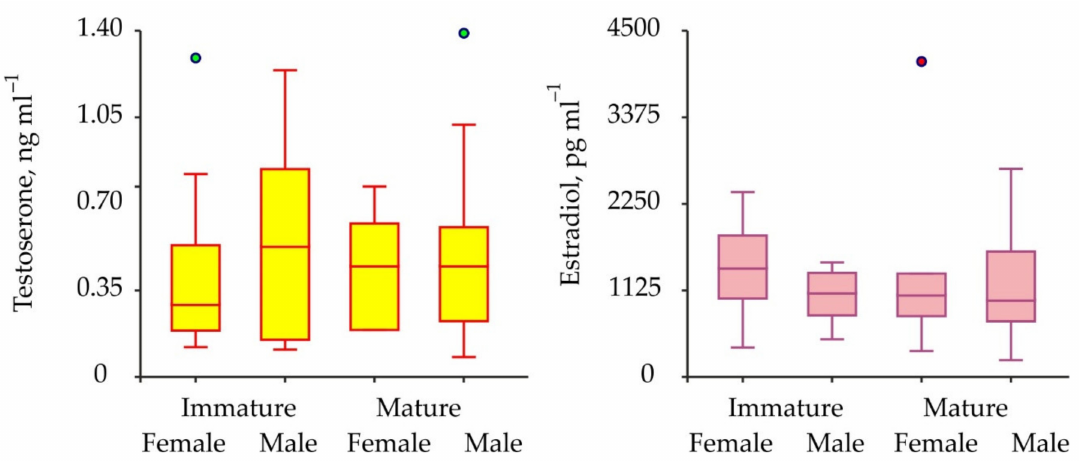
Figure 3. Variations of sex hormones in immature and mature red king crabs from the coastal zone of the Barents Sea. Green and red circles are